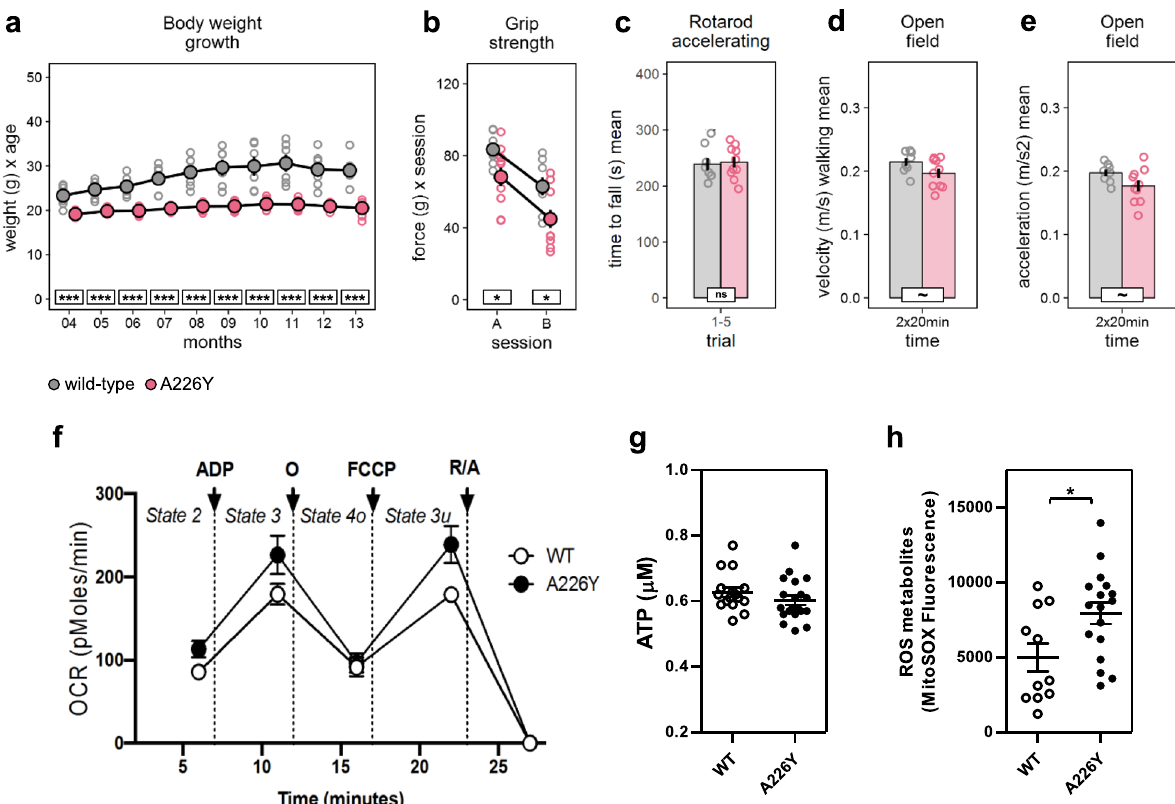
Fig. 1 Body weight, behavioral phenotype, and mitochondrial function. Graphs show untransformed mean, SEM and individual data points (gray/white = wild-type mice, red/black = A226Y mice). *** p < 0.001, ** p < 0.01, * p < 0.05, ~ p < 0.1, ns p ≥ 0.1. a Body weight from 4 to 13 months of age (months F1,115 = 87.06, p < 0.0001, η ² = 0.43; genotype F1,11 = 39.76, p < 0.0001, η ² = 0.78; genotype× months F1,115 = 5.233, p = 0.0240, η ² = 0.04, Box-Cox λ 0.0). b Forepaw grip strength, assessed during 2 subsequent test sessions of 5 trials (session F1,16 = 29.39, p < 0.0001, η ² = 0.65; genotype F1,16 = 9.307, p = 0.0076, η ² = 0.37; genotype × session F1,16 = 0.126 ns). c Time to fall off the accelerating rotarod, average of 5 trials (genotype F1,16 = 0.050 ns). d Average velocity during walking bouts in the large open- fi eld arena (genotype F1,16 = 3.320, p = 0.0872, η ² = 0.17). e Average acceleration during walking bouts in the large open- fi eld arena (g e notype F1,16 = 3.672, p = 0.0734, η ² = 0.19, Box-Cox λ − 0.5). f The oxygen consumption rate (OCR) was